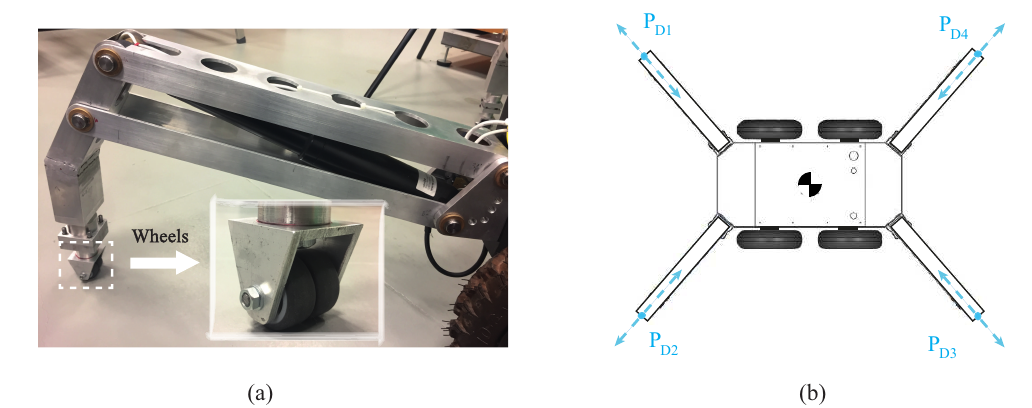
Figure 6. Relative movement of the support point P E and P D .